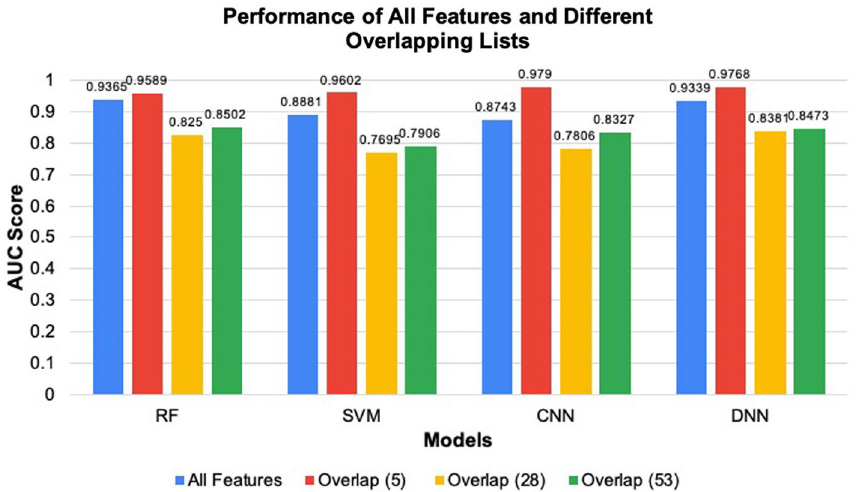
Figure 4. Comparing the AUC results of different genes lists. The blue bar is for the whole DEGs list (924 genes), the red bar is the overlapping list of LASSO and Ridge (5 genes). The yellow bar is the overlapping list of the six ranking algorithms (28 genes), and the green is the overlapping list of the ranking algorithms excluding MCC (53